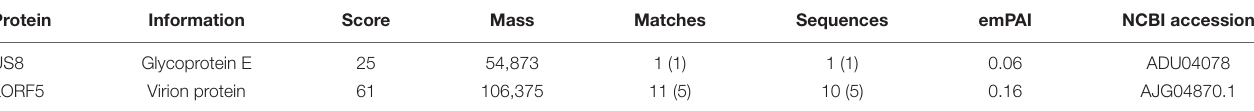
FIGURE 2 | Construction and identification of recombinant viruses. (A) Rescue of the LORF5-deleted mutant and its revertant virus. Plasmids from a positive colony were transfected into DEF cells by Lipofectamine 3000, and with continuous observation, the recombinant virus fluorescent marker protein EGFP was expressed in DEFs. (B) PCR identification of LORF5 gene deletion (245 bp) or restoration (968 bp) using primers (cid:49) LORF5-F and (cid:49) LORF5-R compared with the parental virus DPV CHv-BAC and the US8 gene (1,473 bp) as a DPV gene control. (C) RFLP analysis. The (cid:49) LORF5, R (cid:49) LORF5, and BAC plasmids extracted by the Qiagen Plasmid Midi Kit were cut with restriction enzymes Eco RI or Xho I and then imaged by 1% gel electrophoresis; the left is the simulated imaging after restriction digestion. The arrows in the figure show the difference between the deletion strain with WT and the reverting strain after digestion. The corresponding LORF5 gene-deleted strain has a band around 4 kb after Eco RI digestion, and a band around 3 kb has been added. (D) Reverse-transcription q-PCR was performed to verify the mRNA expression of the gene LORF5 and surrounding genes UL55 and LORF4 of the viruses. TABLE 1 | Viral content of DPV extracellular virions (partial).